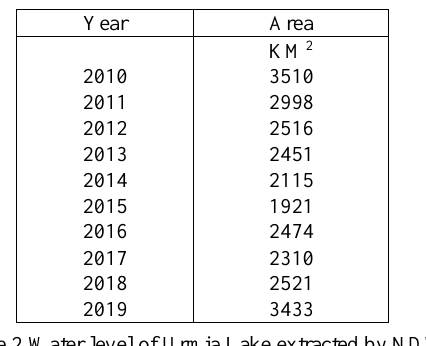
Table 2.Water level of Urmia Lake extracted by NDWI